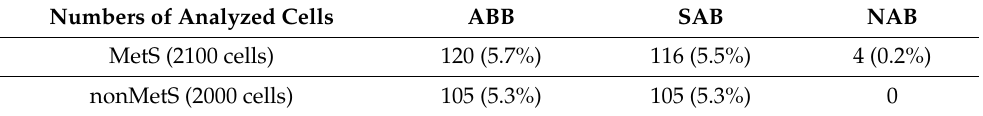
Table 2. Group analysis; the total number of aberrated cells in all